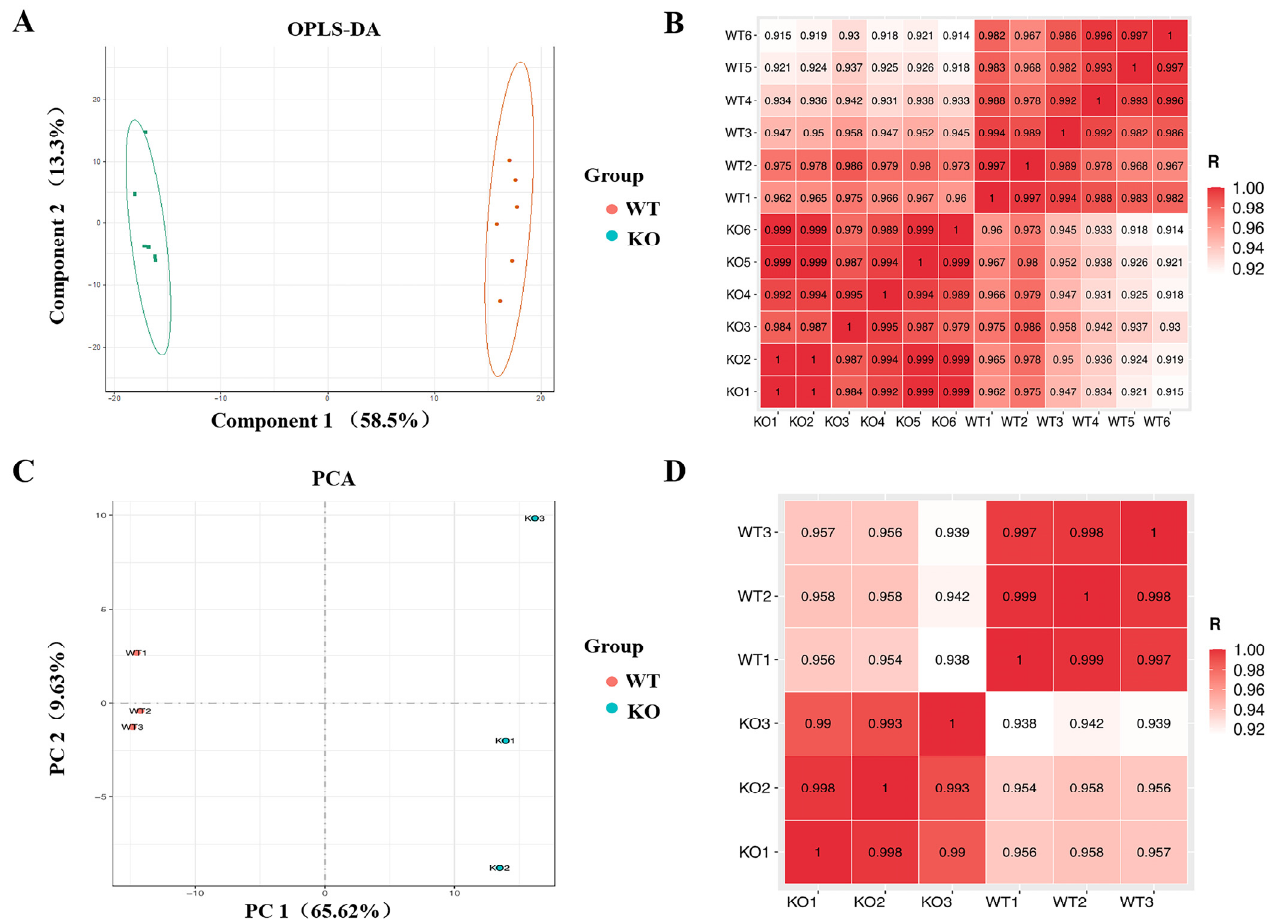
Figure 1. Assessment of data quality for metabonomic and transcriptome analysis. ( A ) Metabolite partial least squares discriminant analysis (OPLS-DA) ( n = 6). ( B , D ) Correlation analysis between samples, with colors indicating the strength of correlation. ( C ) Transcriptomics data principal component analysis (PCA) ( n = 3).